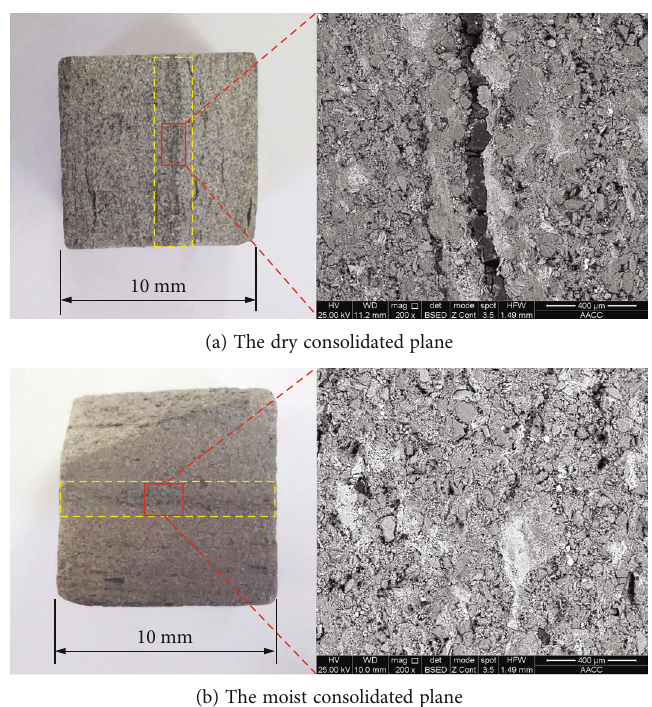
Figure 5: Macro- and mesoscopic topography of consolidated plane before and after humidi fi